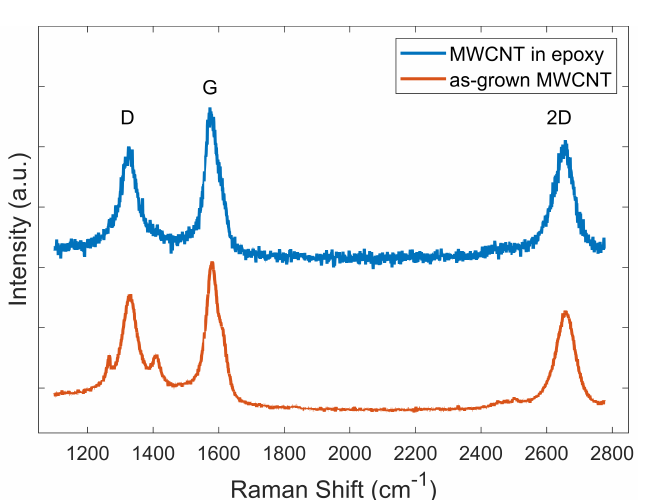
Figure 6. Raman spectra of MWCNTs from the cross-sectional fractured edge of composite specimens and from the as-grown MWCNTs dispersion in silicone